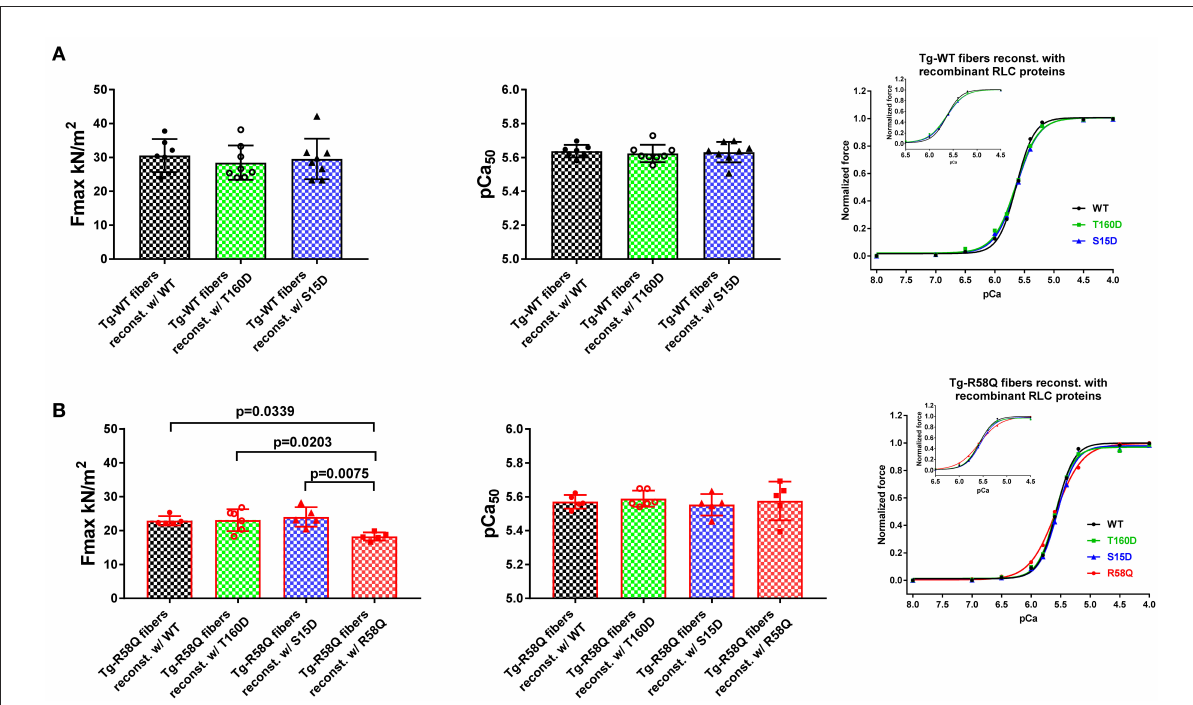
FIGURE4 Contractile function in skinned LVPM from Tg-WT (A) and Tg-R58Q (B) mice reconstituted with recombinant RLC proteins. Maximal force (left panels), Calcium sensitivity of force (middle panels), and force-pCa relationships (right panels) were measured in LVPM from Tg-WT and Tg-R58Q preparations depleted of endogenous RLC and reconstituted with recombinant WT-RLC (black), T160D (green), S15D (blue), and R58Q (red) proteins. For Tg-WT fibers reconstituted w/WT, n = 7 fibers, w/T160D, n = 8, and w/S15D, n = 8, and Tg-R58Q reconstituted w/WT, n = 5, w/T160D, n = 6, w/S15D, n = 5, and w/R58Q, n = 5. Data are the average ± SD of n = N ◦ fibers per group with the significance calculated by one-way ANOVA with Tukey’s multiple comparison test (for F max and pCa50 values, p -values presented in the graph), or two-way ANOVA with Tukey’s multiple comparison test (for the force-pCa